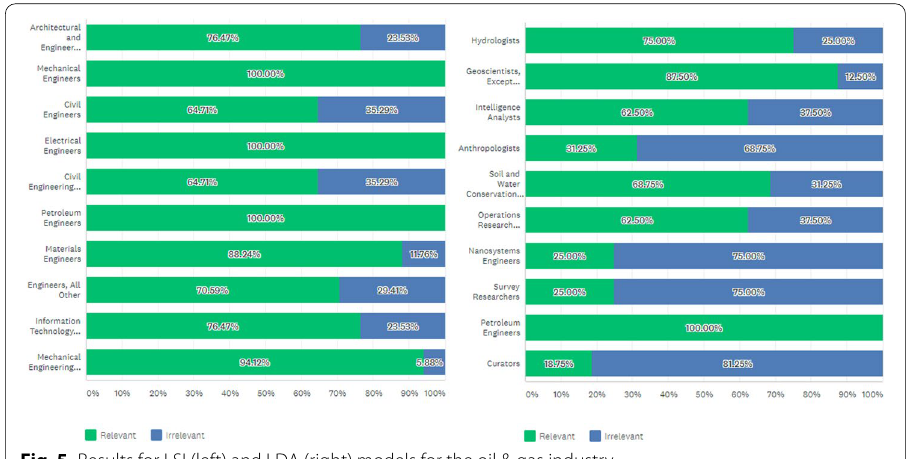
Fig. 5 Results for LSI (left) and LDA (right) models for the oil & gas